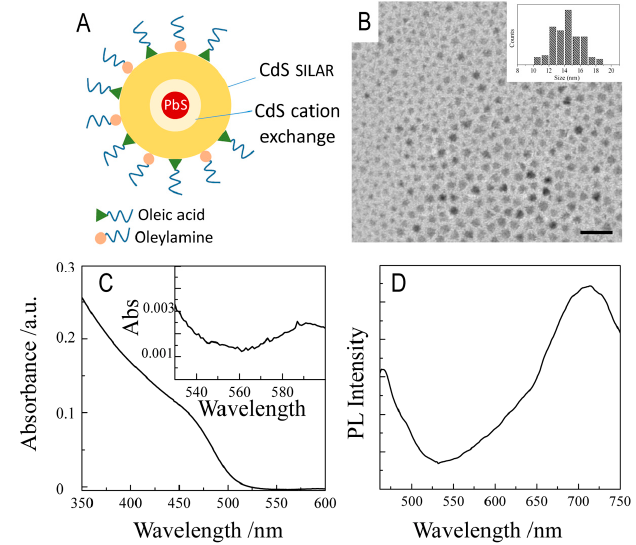
Figure 1. Sketch of the giant PbS@CdS@CdS NCs ( A ) and TEM micrograph ( B , scale bar 50 nm) with size statistical analysis ( B , inset), UV-Vis absorption ( C ) and photoluminescence ( D , λ ex = 400 nm, T = 294 K) spectra of the core–shell–shell sample. The absorbance profile in the 540–600 nm wavelength range has been enlarged in the inset of panel C.